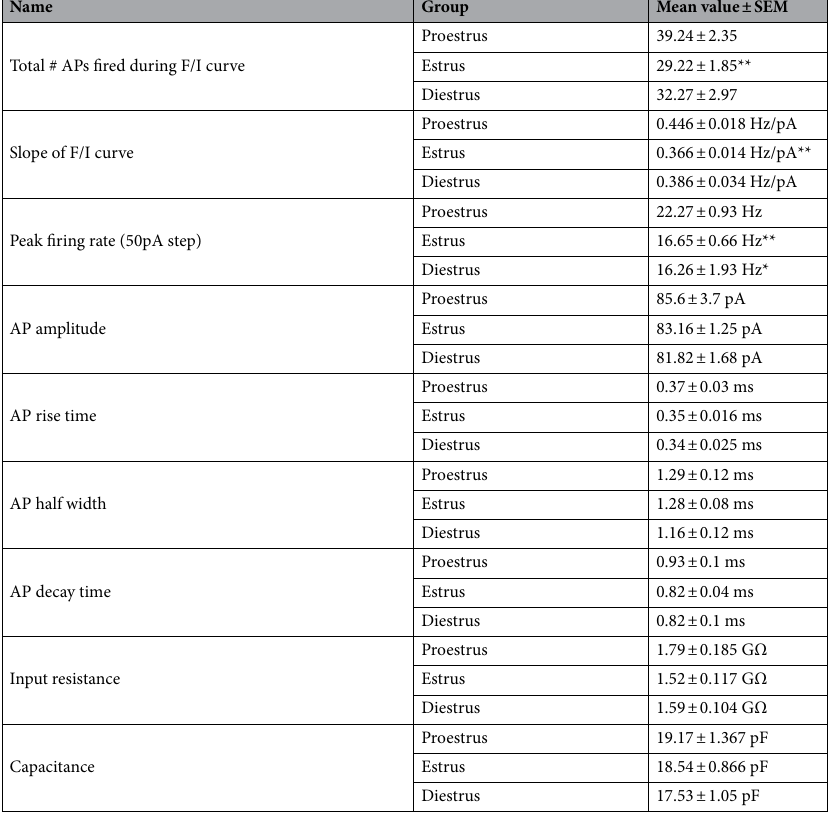
Table 1. Electrophysiological properties of CRH neurons at different stages of the estrous cycle. Mean values for each group (proestrus, estrus and diestrus) for the listed properties. Stars indicate statistical significance with the proestrus group (full statistical results given in Supplementary Table 1). AP stands for action potential. P values: * ≤ 0.05, ** ≤